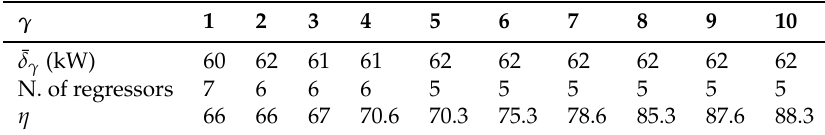
Table 2. Results of the model